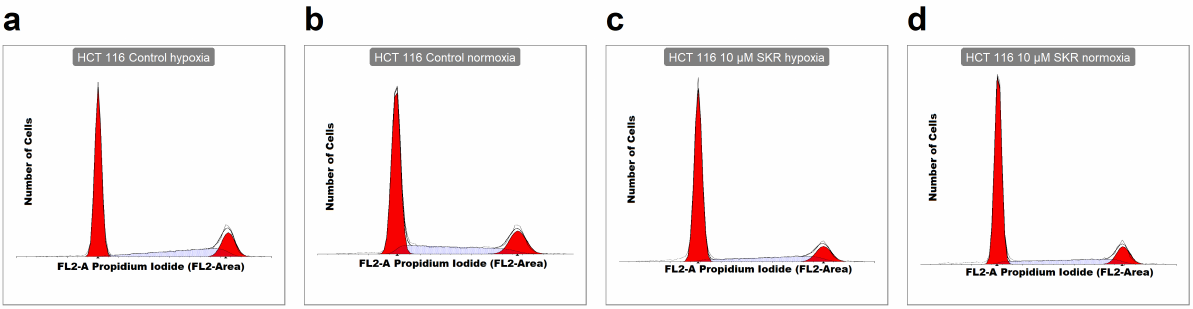
Figure 2. The effect of SKR on phosphatidylserine externalization in cancer cell lines HCT 116 and HT-29. ( a – h ) Representa- tive FACS plots of debris-free singlets after SKR treatment in HCT 116 and HT-29 cell lines. ( i ) Ratios between the numbers of cells in gates stained with Annexin-V and PI as an average of at least three independent experiments. ( j ) Significantly increased number of apoptotic cells after treatment with SKR after 48 h in HCT 116 cell line. Control samples contain the same amount of DMSO as the sample with SKR. The results are expressed in boxplots or as average in bar plots of three independent experiments. The experimental groups were compared with the control group. The number of samples (n) is noted in plots. (*** p <